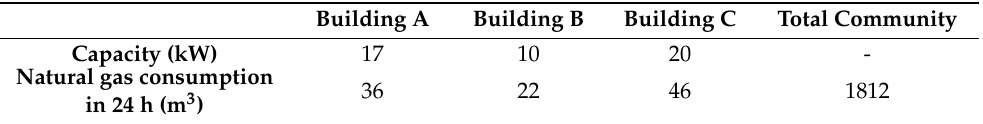
Table 8. The capacity of the boiler and natural gas consumption in the